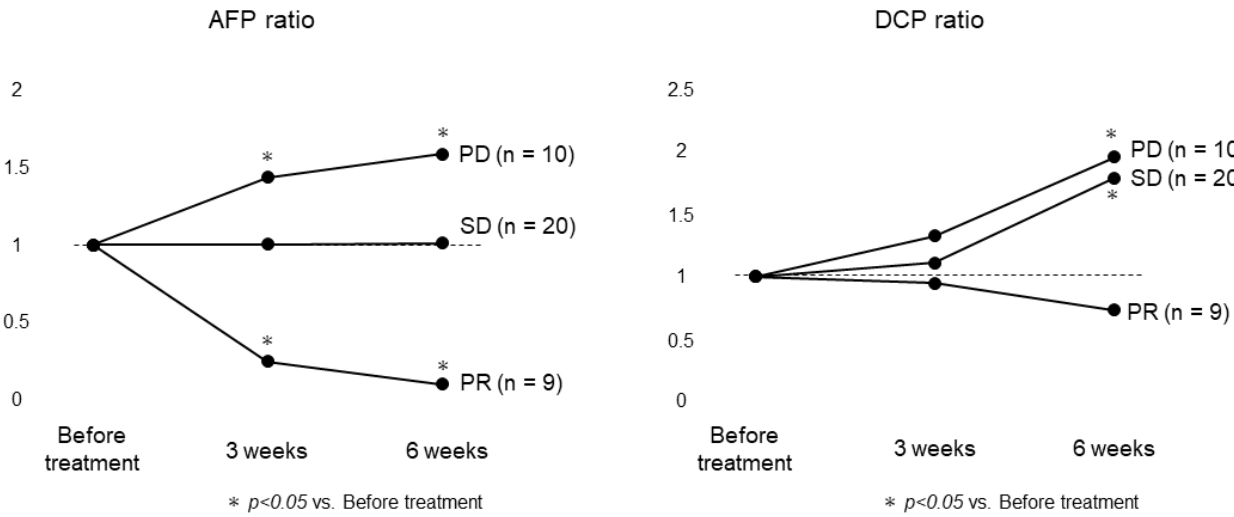
Figure 1. Changes in AFP and DCP ratios for each response based on mRECIST. In 9 patients with partial response, the AFP ratio at 3 and 6 weeks decreased with a statistically significant difference, and increased with a statistically significant difference in 10 patients with progressive disease. On the other hand, the DCP ratio increased with a statistically significant difference at 6 weeks in patients with stable disease or progressive